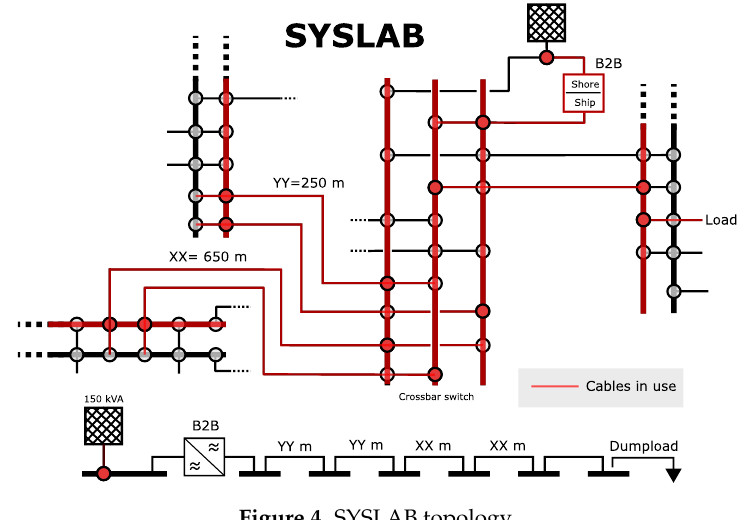
Figure 4. SYSLAB topology.